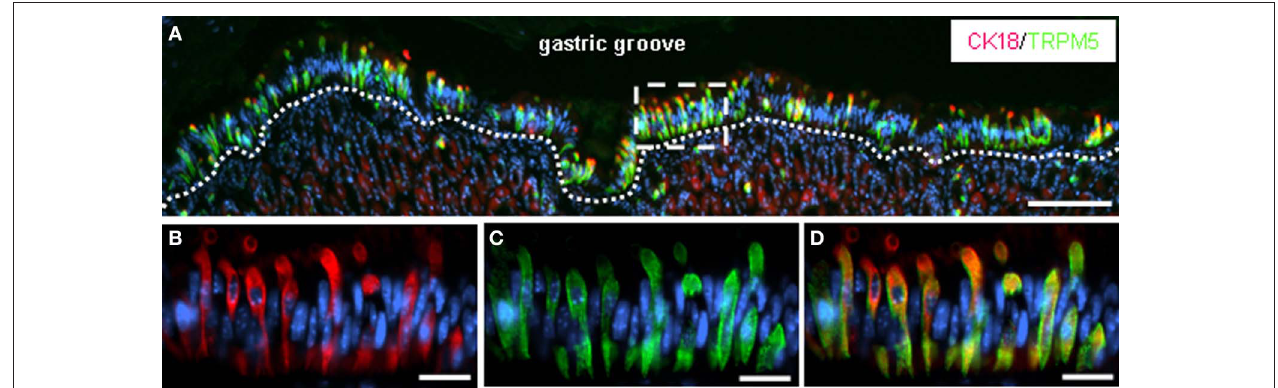
FIGURE 2 | CK18-positivebrushcellsliningtheboundarybetweenfundus and corpus are immunoreactiveforTRPM5. (A) Double-immunolabelingof cryosectionsthroughthe gastric mucosaat thejunction betweenfundusand corpuswith specificantibodiesagainst CK18 (red) and TRPM5 (green) .The overviewof theapical corpusmucosaadjoiningthefundusepitheliumshowsa strikingly highnumberof CK18-/TRPM5-immunoreactivebrush cells all along the course of the “limiting ridge” facing the lumenof the“gastric groove.”